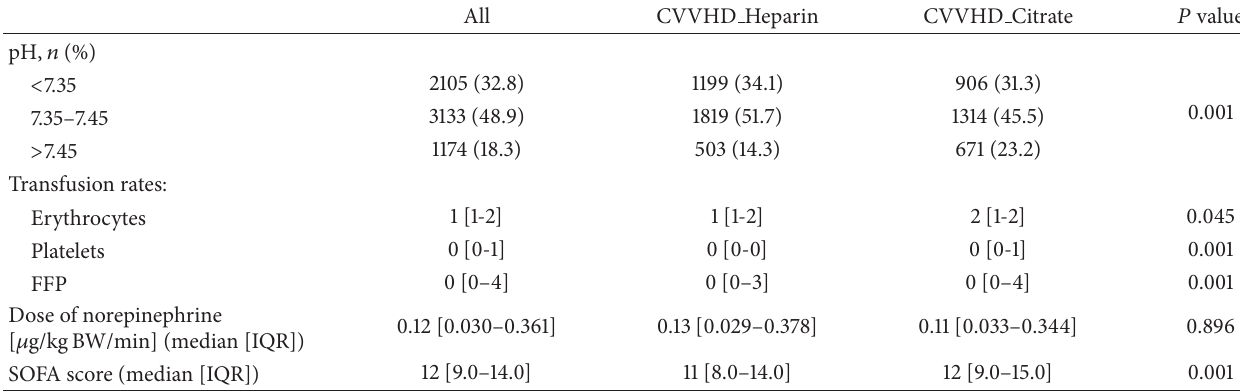
Table 6: Side effects during renal replacement therapy among the study